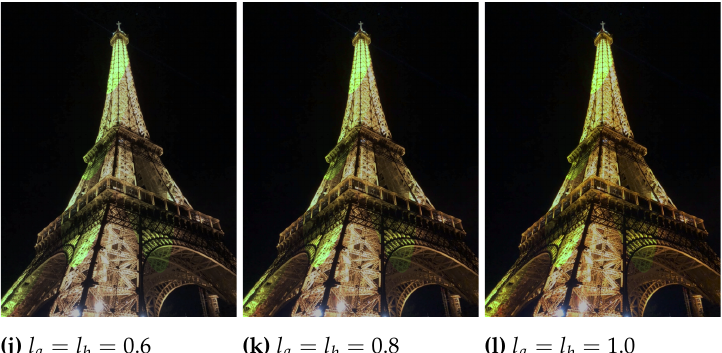
Figure 11. Parameter changing results in Lab color space (Fixed l l = 0.75 with respect to l a and l b ).